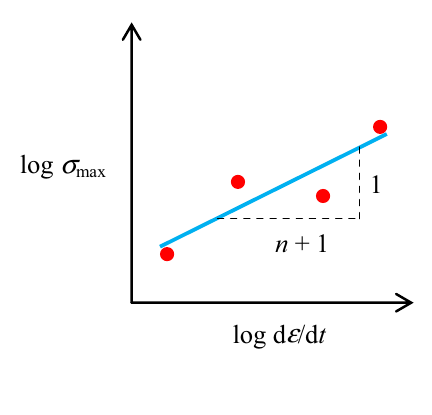
Fig. 9 Calculation of n